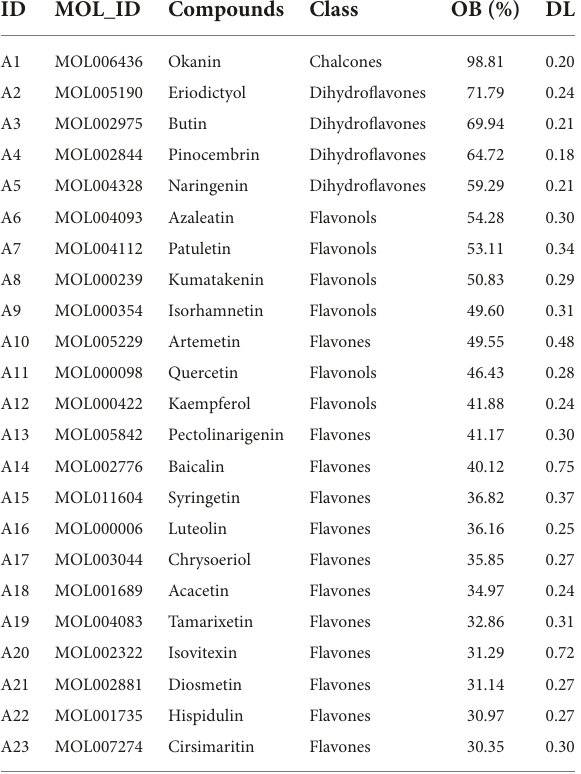
TABLE 2 Identification of common potential active compounds from A. argyi and A. indica